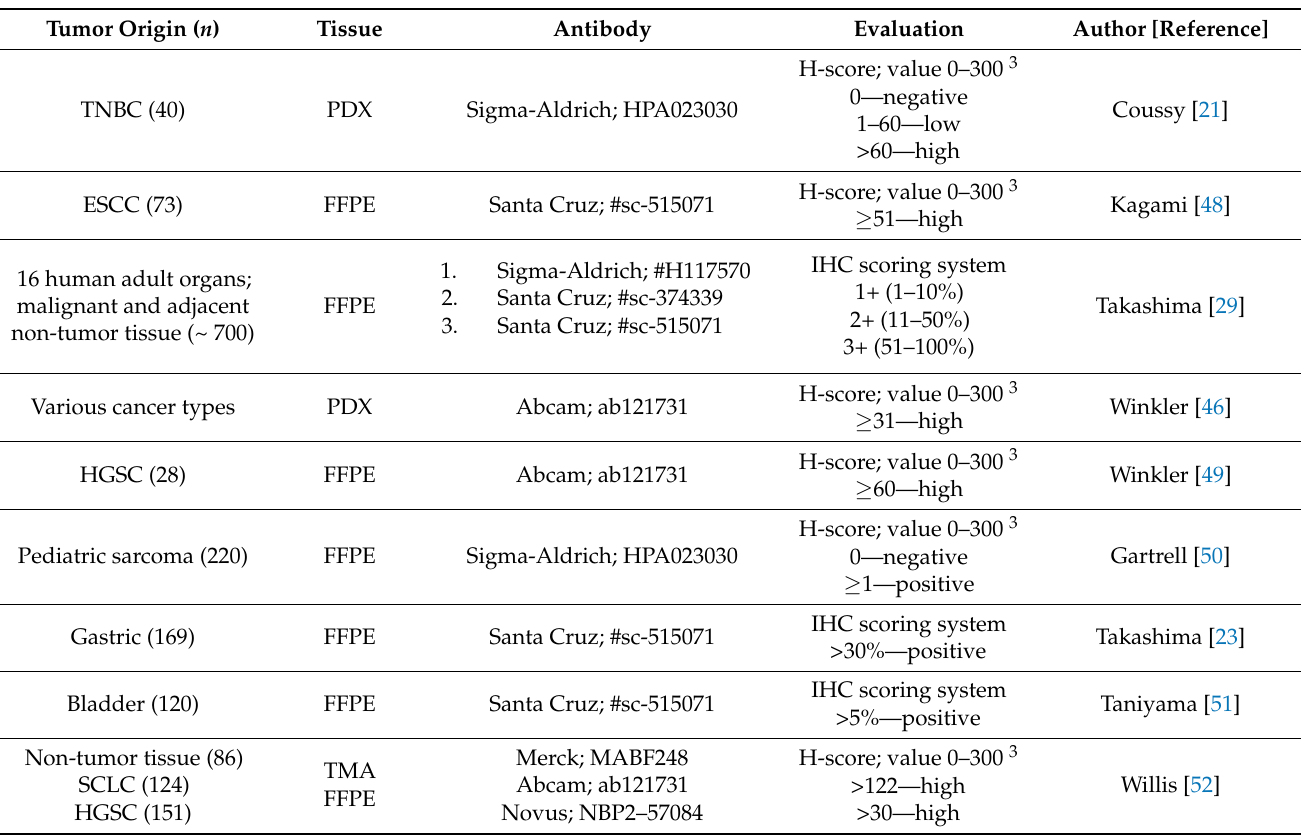
Abbreviations: n = number of patients/samples, CRC = colorectal cancer, OC = ovarian cancer, HGSC = high- grade serous carcinoma, SCLC = small cell lung cancer, TNBC = triple-negative breast cancer, ESCC = esophageal squamous cell carcinoma, DX = patient-derived xenograft, FFPE = Formalin-fixed paraffin-embedded blocks, TMA = tissue microarray. 1 HS = intensity (0 . . . none; 1 . . . weak; 2 . . . moderate; 3 . . . strong) +